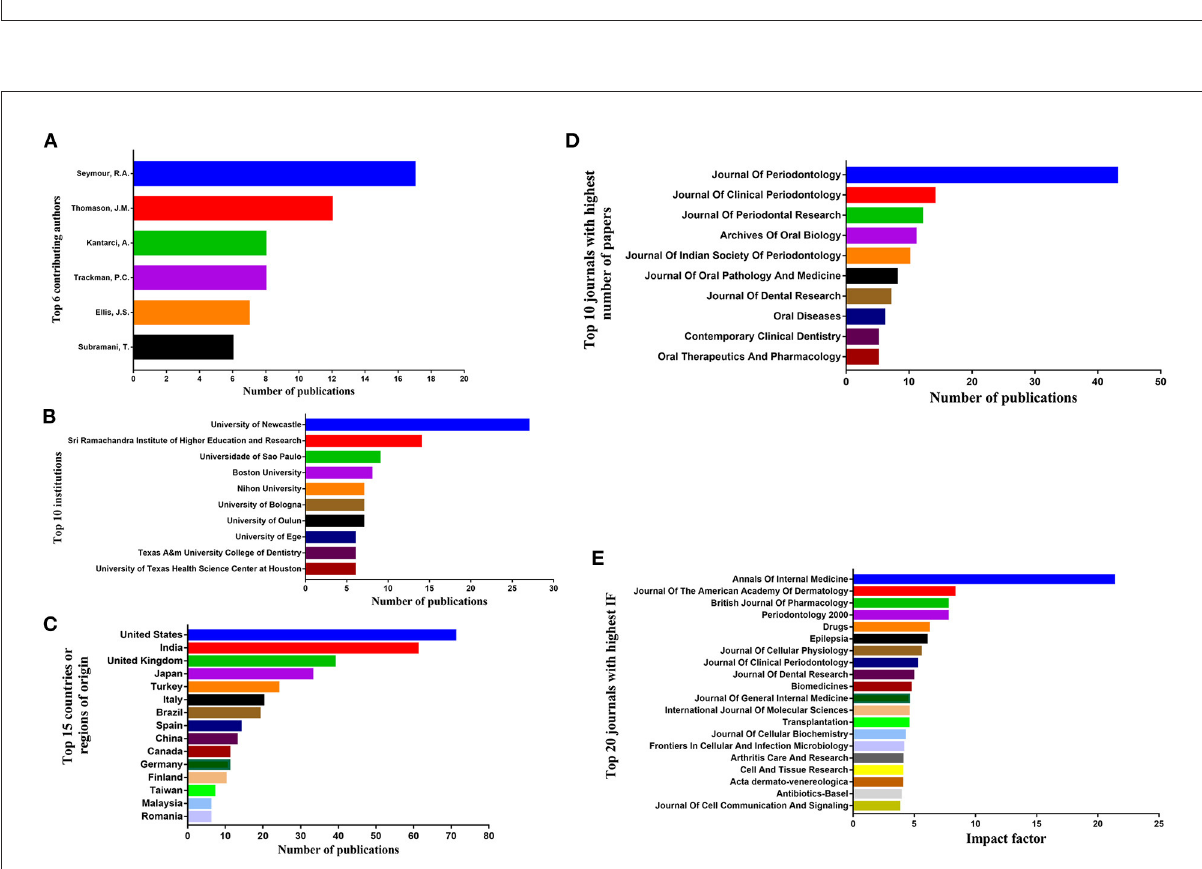
FIGURE3 The information on the (A) author (rank 1–6), (B) institution (rank 1–15), (C) country or region of origin (rank 1–15), (D) journal of publication (rank 1–10) with the largest number and (E) journal with high IF (rank